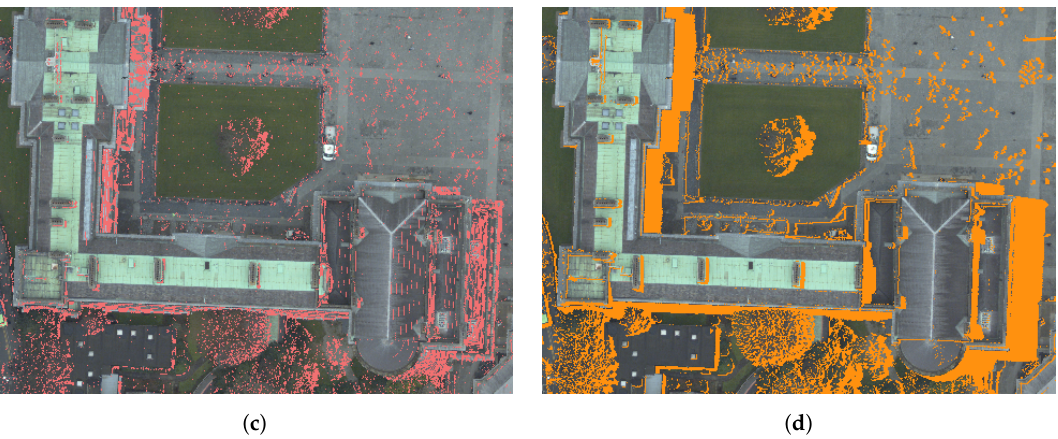
Figure 17. Results of occlusion detection using the Z-buffer and angle-based methods: ( a ) perspective image, ( b ) differentially-rectified orthophoto, ( c ) detected occlusions using the Z-buffer technique, and ( d ) detected occlusions using the angle-based method. Pixel size is equal to 10 cm in the orthophotos.